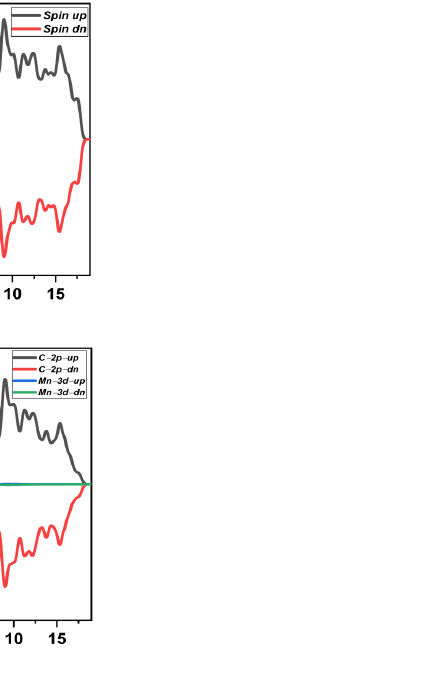
Figure 7. Spin-polarized energy of ( a ) total density of state (TDOS) and ( b ) partial DOS of double ( Mn +2 )-doped 3C-SiC.Fermi level denoted by a red dash line. Using a simple two-level model, we can see how the magnetic state at the ground with the highest probability would be formed, as shown in Figure 8a,b. The unperturbed exchanges split of 3d orbitals on the isolated Mn1 and Mn2 are on the left side for FM ar- rangement and on the right side for AFM arrangement, respectively. In the FM ar- rangement, both nonbonding and antibonding levels of one spin are partially occupied, which results in energy gain due to the FM interaction. However, in the AFM arrange-